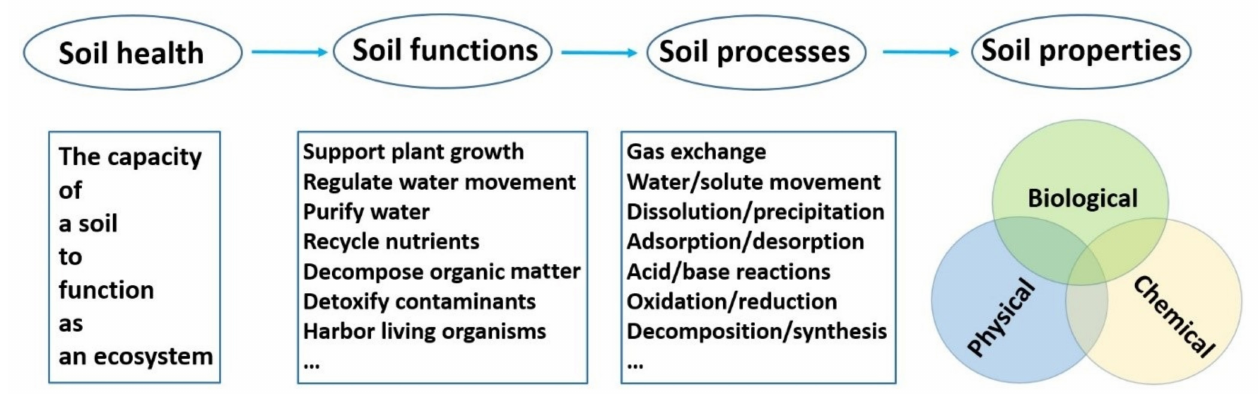
Figure 1. Soil health as a comprehensive expression of various soil